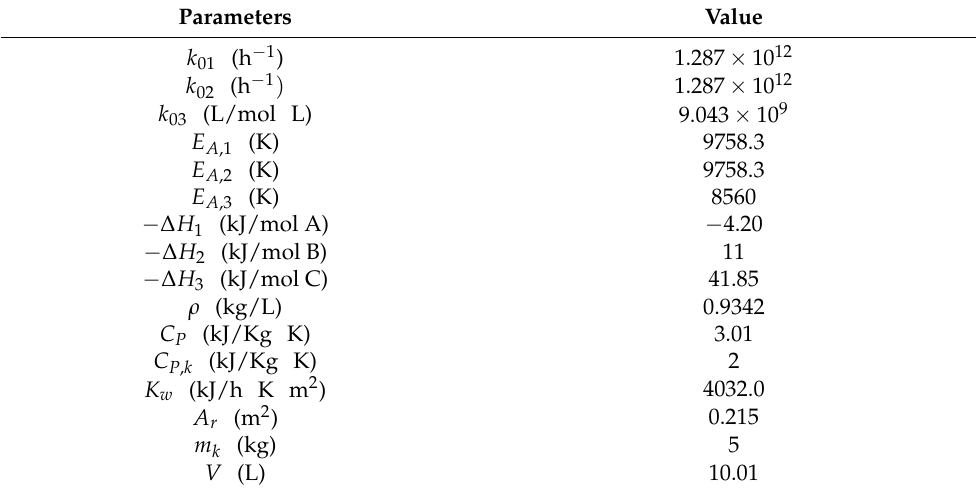
Table 1. Van de Vusse CSTR